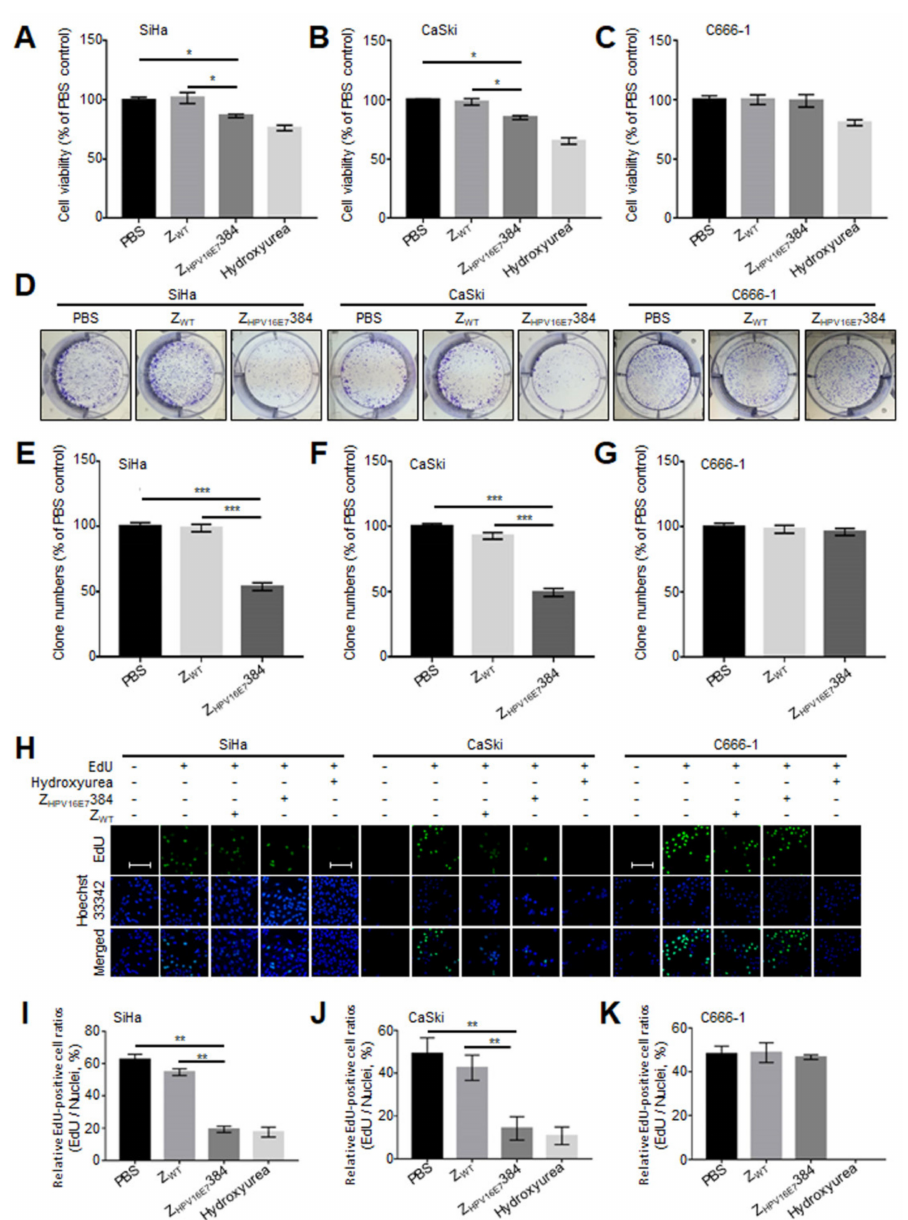
Figure 2. Z HPV16E7 384 significantly inhibited the proliferation of the target cells (SiHa and Caski) ( A – C ) A cell viability assay was performed to evaluate the effect of Z HPV16E7 384 on the target cells. Cells treated with Z WT or PBS were used as the negative controls while those treated with hydroxyurea were used as the positive controls. ( D ) A colony formation assay was performed to evaluate the suppression of cell proliferation by Z HPV16E7 384. ( E – G ) The clone numbers in ( D ) were counted. ( H ) An EdU proliferation assay was performed to further evaluate the suppression of cell proliferation by Z HPV16E7 384. Cell proliferation was determined by the incorporation of EdU (green). Cell nuclei were counterstained with Hoechst 33342 (Blue). Scale bar = 100 µ m. ( I – K ) The ratio of EdU-incorporating live cells was calculated. The data shown are representative of three independent experiments. All experiments were performed in triplicate and data are expressed as the means ± SD ( n = 3). * p < 0.05, ** p < 0.01, *** p <